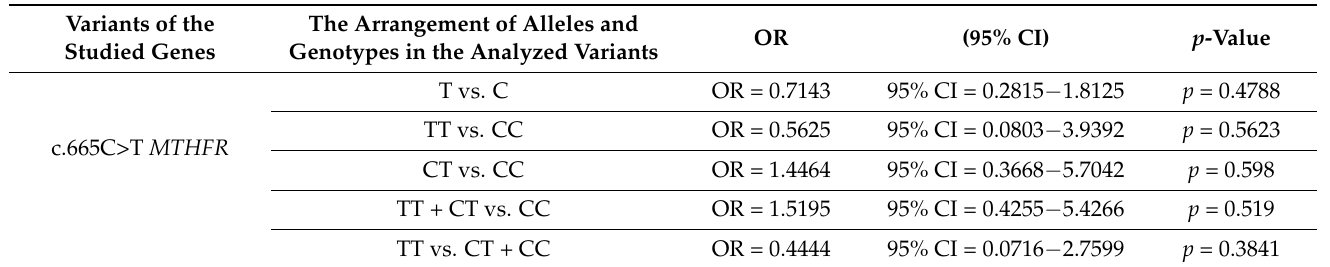
Table 9. Genetic association studies of the folate pathway genes as maternal risk factors for having a child with Down